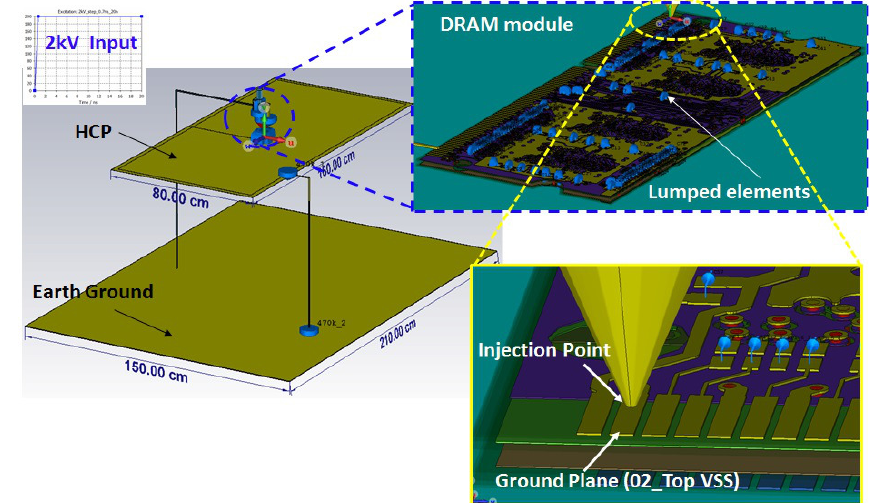
Figure 9. Simulation setup for the current distribution analysis of the DDR3 memory module (the dielectric layers of the DDR3 model shown in stack-up of Figure 8a are included in full-wave simulation but are hidden in the above depicted figure for the clarification of conductor layers and ESD injection